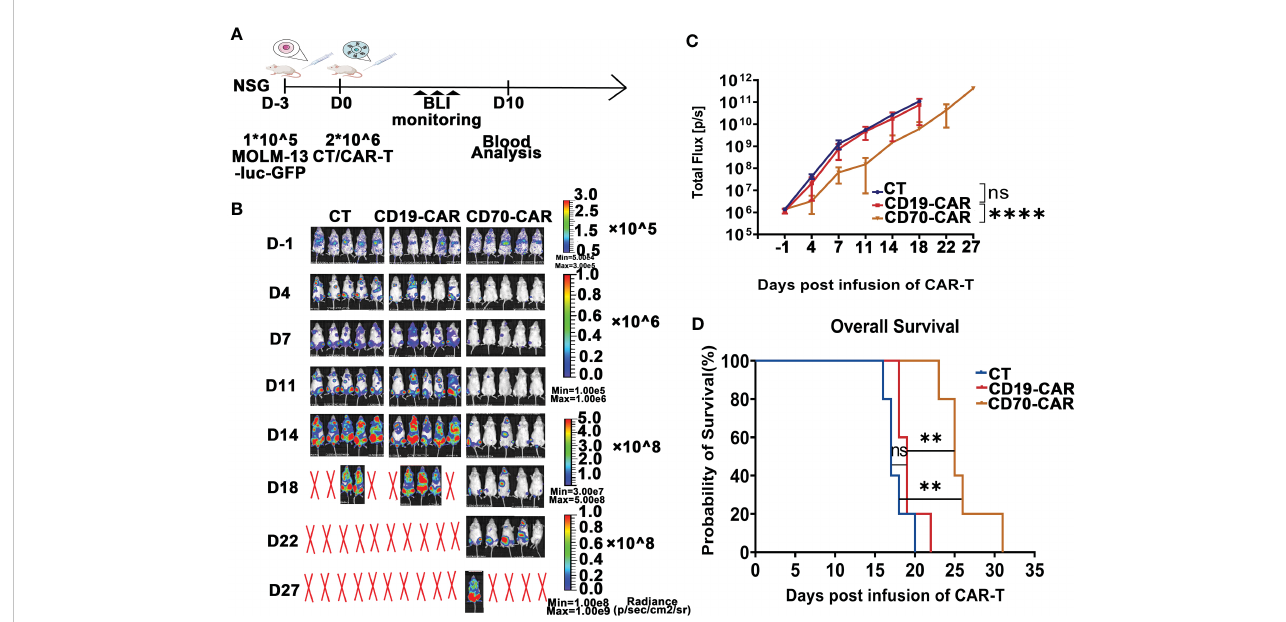
FIGURE 4 Anti-CD70 CAR-T cells exhibit a high capacity to reduce AML tumor burden and prolong survival time. (A) , Scheme of experimental design. On day 10, venous blood collected from orbital vein was used for complete blood count (CBC) and biochemistry tests. (B) , Molm-13 cells (1.0 × 10 5 ) expressing luciferase-GFP were intraveously injected into NSG mice. Three days later, CAR-T or control T cells (2.0 × 10 6 ) were given by intravenous injection. Bioluminescence imaging (BLI) was used to monitor leukemia burden at the indicated times. (C) , Leukemia burden (total fl ux) quanti fi ed in mice treated with control T cells, CD19-CAR-T, and CD70-CAR-T cells at the indicated days. One-way ANOVA, post hoc was Tukey ’ s test. **** P <0.0001; ns means no signi fi cance. (D) , Kaplan-Meyer plot showing mouse survival. P values from log-rank test. ** P <0.01, ns means no signi fi cance.